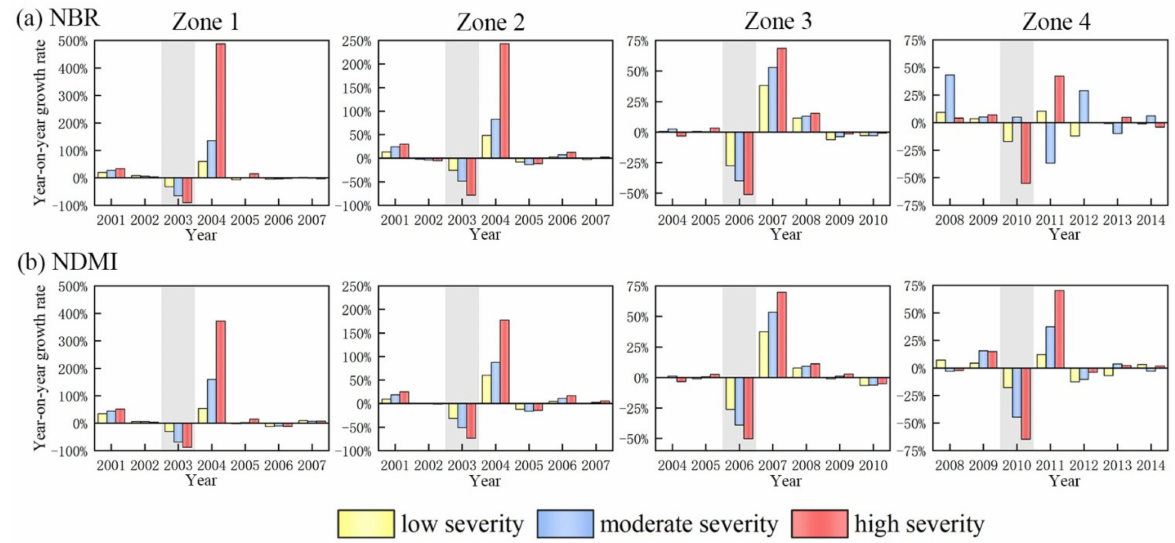
Figure 4. Year-on-year growth rate of ( a ) NBR, ( b ) NDMI. The gray shadow indicates the occurrence of fire